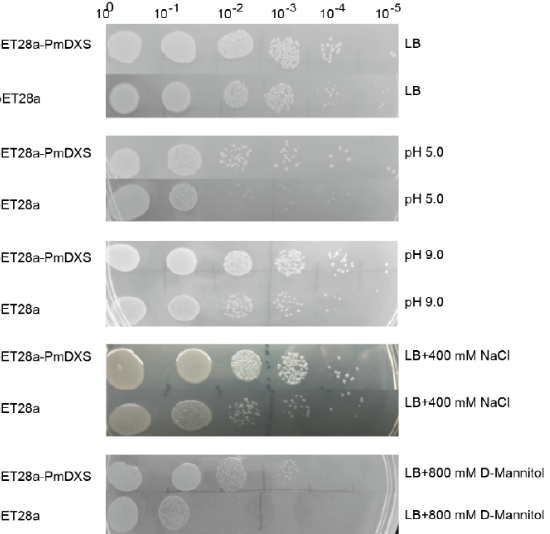
Figure 5. Growth status of recombinant and control bacteria on solid LB medium. The recombinant bacteria (TransB/pET28a − PmDXS) and the control bacteria (TransB/pET28a) were inoculated on solid plates containing LB, 400 mM NaCl, 800 mM D-mannitol, HCl (pH 5.0), or NaOH (pH 9.0). All plates were incubated at 37 ◦ C overnight. 10 0 ~10 − 5 represent the dilution gradients of the E. coli liquid